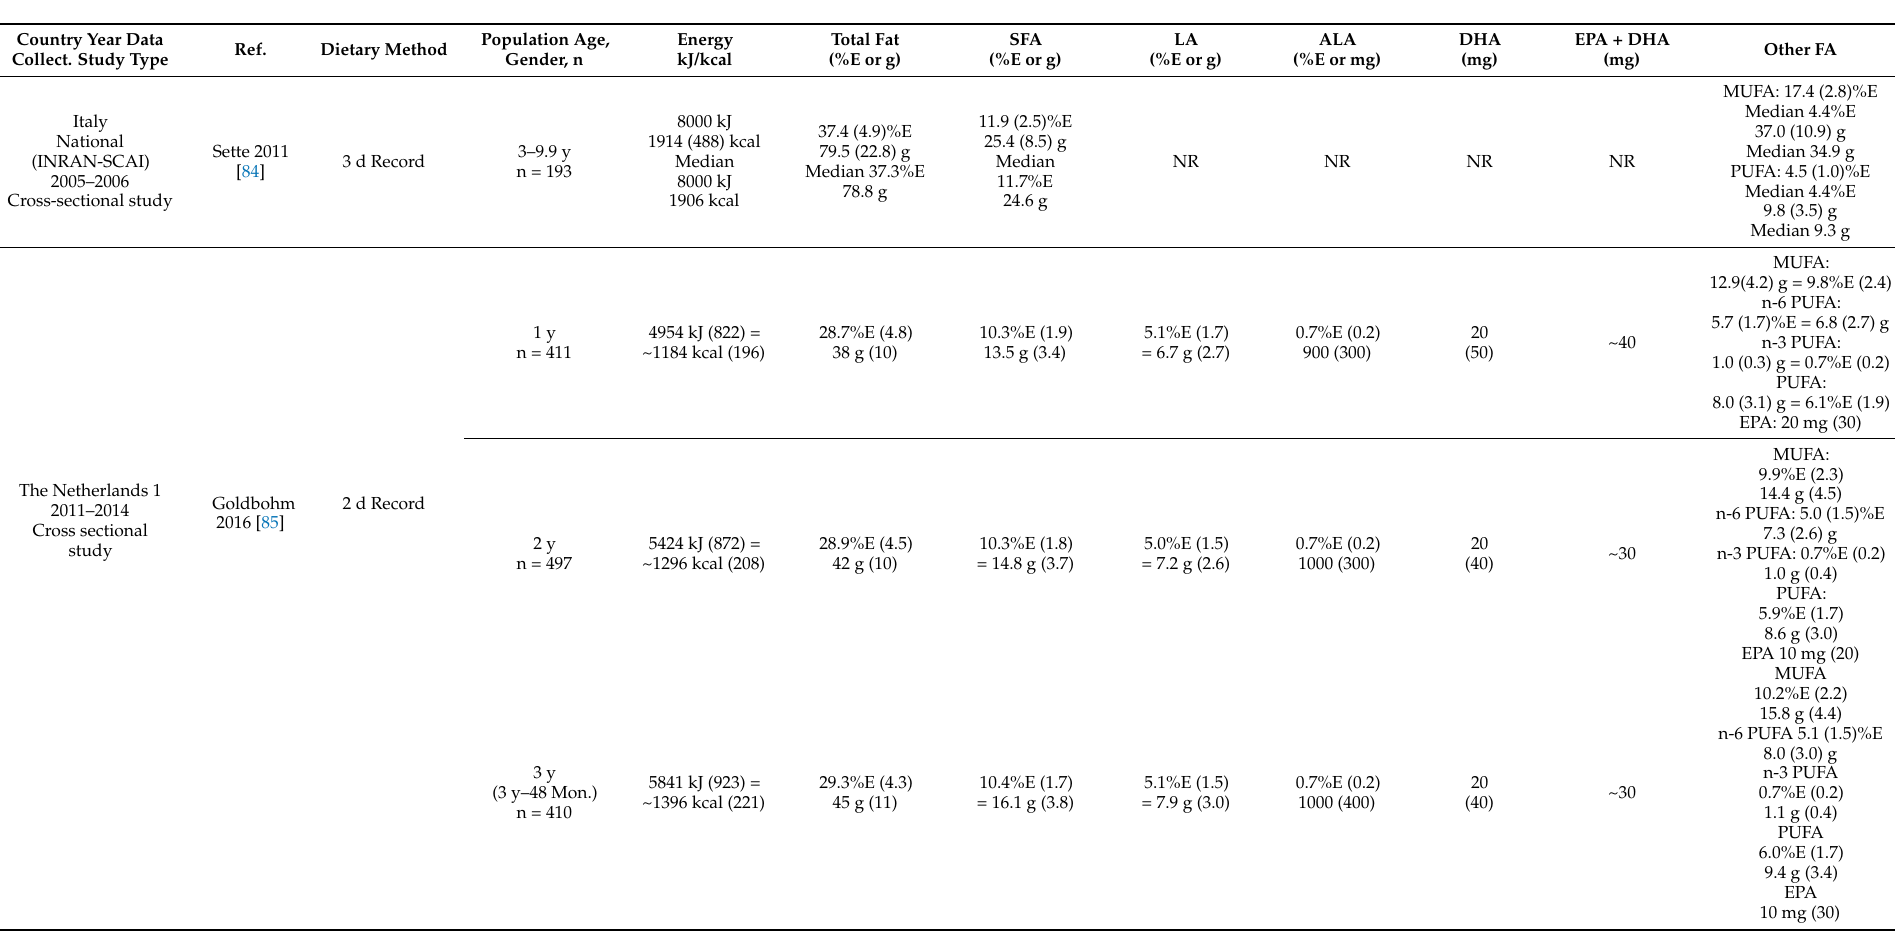
Country Year Data Collect. Study